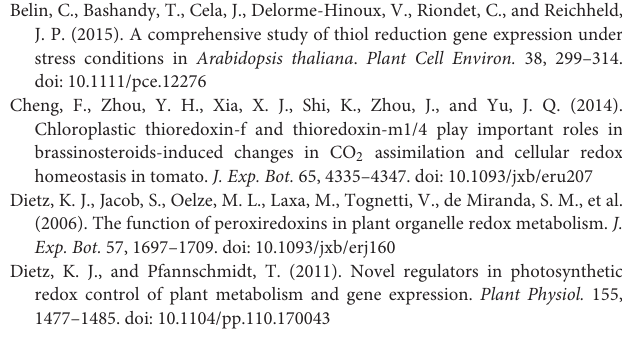
Supplementary Table 1 | Primers for real-time quantitative PCR. Supplementary Figure 1 | qRT-PCR analyses of expressions of NTRC (NADPH thioredoxin reductase C), FTR (ferredoxin thioredoxin reductase), PRXQ (peroxiredoxin Q), PRX2E-1 (peroxiredoxin IIE-1), PRX2E-2 (peroxiredoxin IIE-2), 2CPA (2-cys peroxiredoxin A), and 2CPB (2-cys peroxiredoxin). Values represent the means ± SE ( n = 3). Letters indicate significant differences at P < 0.05 according to Duncan’s multiple range tests. CK, control; S, 150 mM NaCl; M + S, 150 µ M melatonin with 150 mM NaCl. Supplementary Figure 2 | Phylogenetic tree of chloroplastic thioredoxins from Solanum lycopersicum , Pisum sativum and those identified thioredoxins from Arabidopsis . The phylogenetic tree was constructed using MEGA 5 with the Neighbor–Joining method. Bootstrap values calculated from 1000 trials are shown at each node. The extent of divergence according to the scale (relative units) is indicated at the